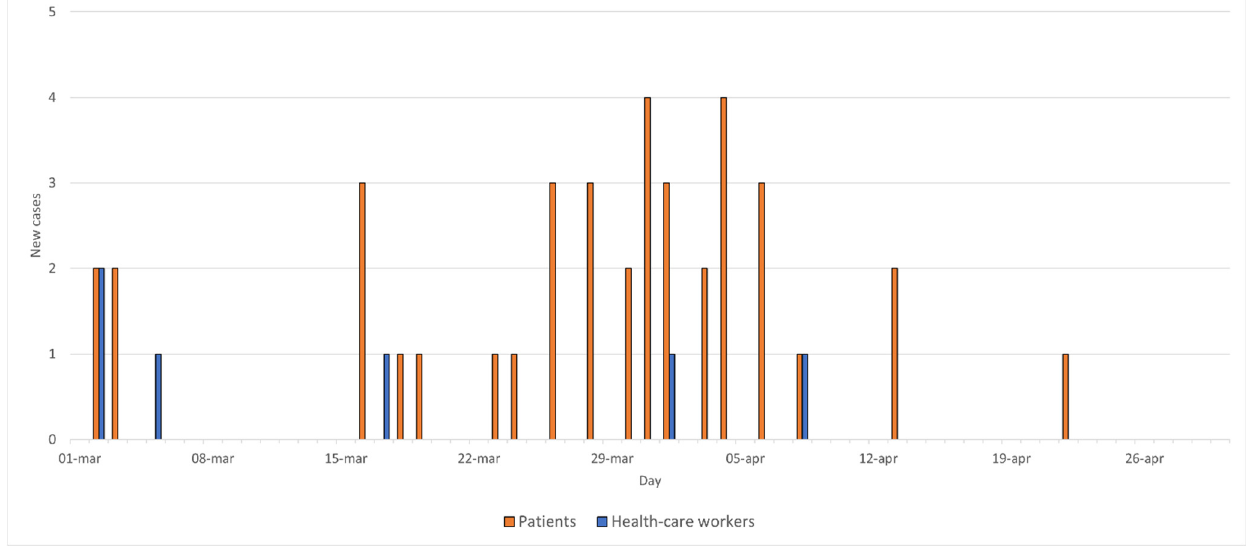
Figure 1. Daily incidence of SARS-CoV-2 during the first wave (SARS-CoV-2 molecular nasopharyngeal swab positive tests).